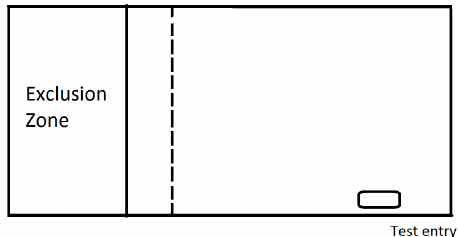
Figure 1. Schematic of the paddock in which sheep were tested in. The small rectangle is the location on the water trough. The warning zone, which is the location in which audios and stimuli were applied is indicated as the dashed line. The solid line is the beginning of the exclusion zone.